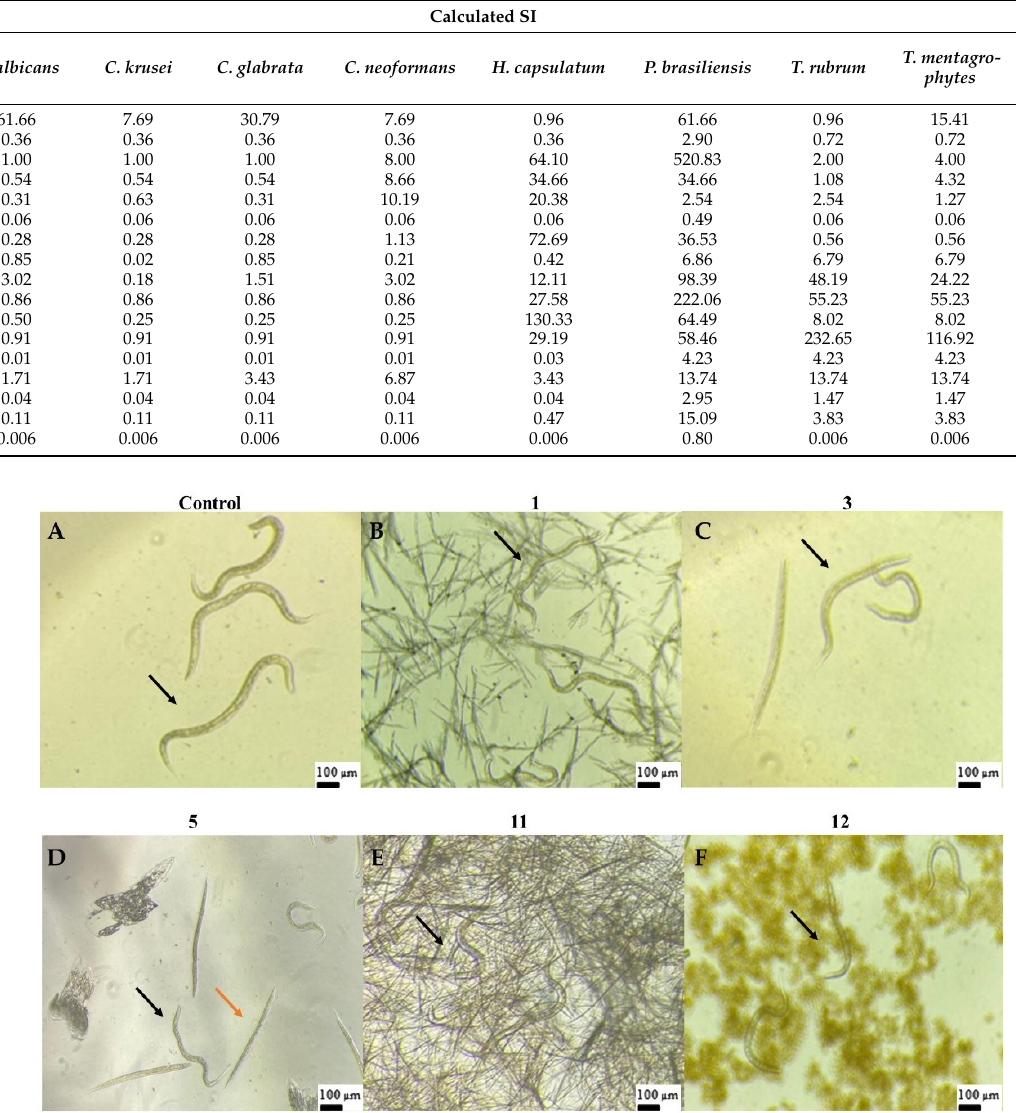
Figure 4. Images of L4 stage Caenorhabtis elegans : 32 larvae at a compound concentration equal to 250 µg/mL. ( A )—control group, the black arrow indicates a live larva, in its sinusoidal form; ( B – F )—representative images of compounds 1 , 3 , 5 , 11, and 12 , respectively; the black arrows point to a live larva in its characteristic shape (sinusoidal) and the orange arrow shows a dead larva in its characteristic rod shape.